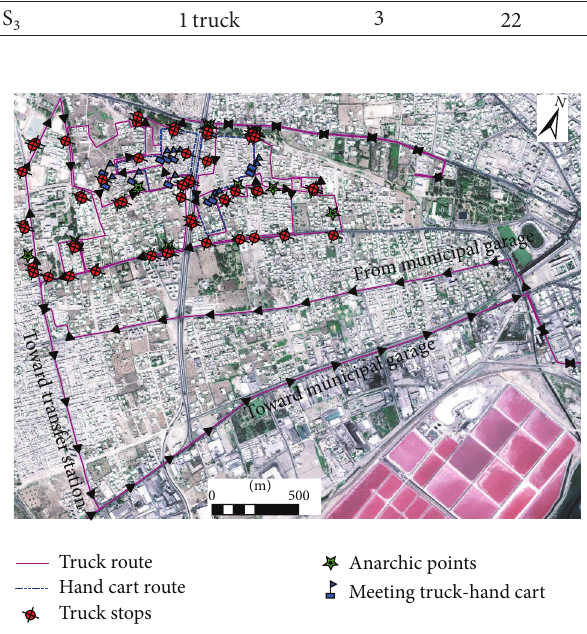
Figure 5: Current collection route (Scenario S0).